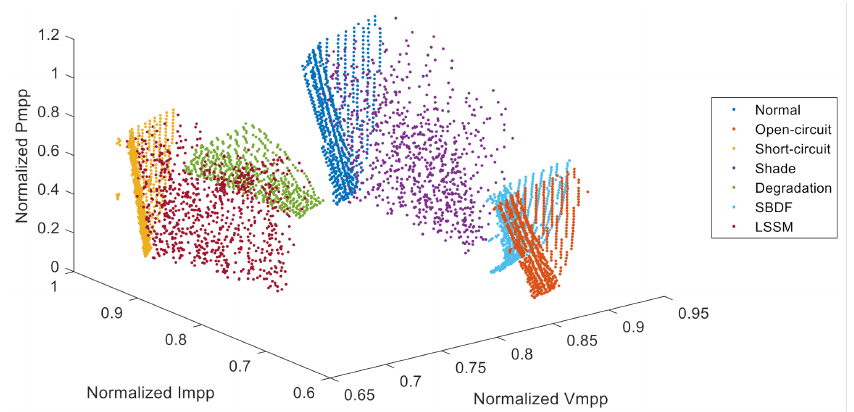
Figure 8. The normalized MPP data of PV array under normal and fault